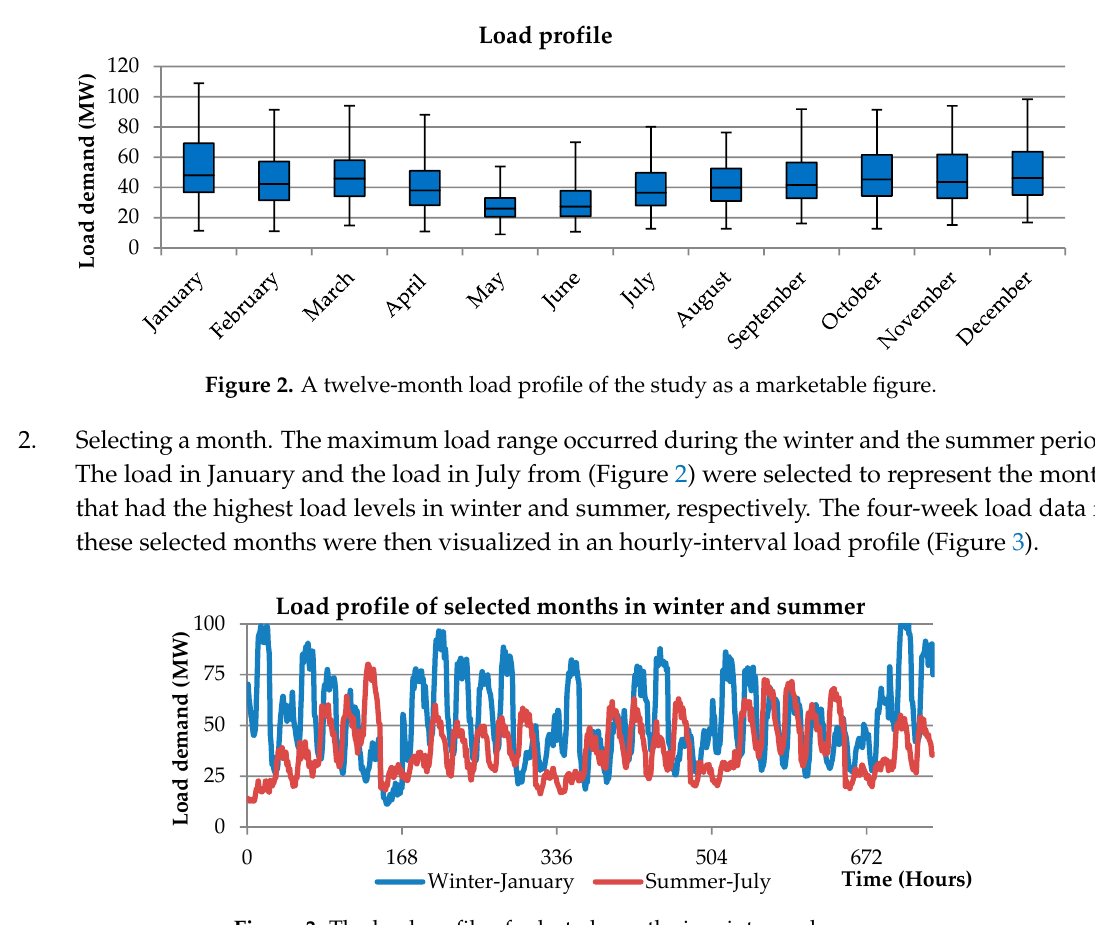
Figure 3. The load profile of selected months in winter and summer.